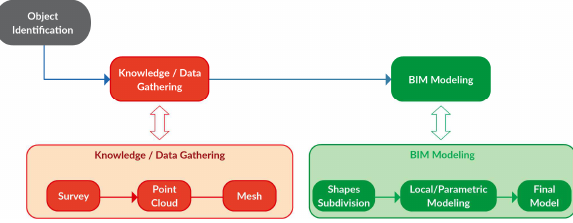
Figure 2. Workflow with internal BIM modeling